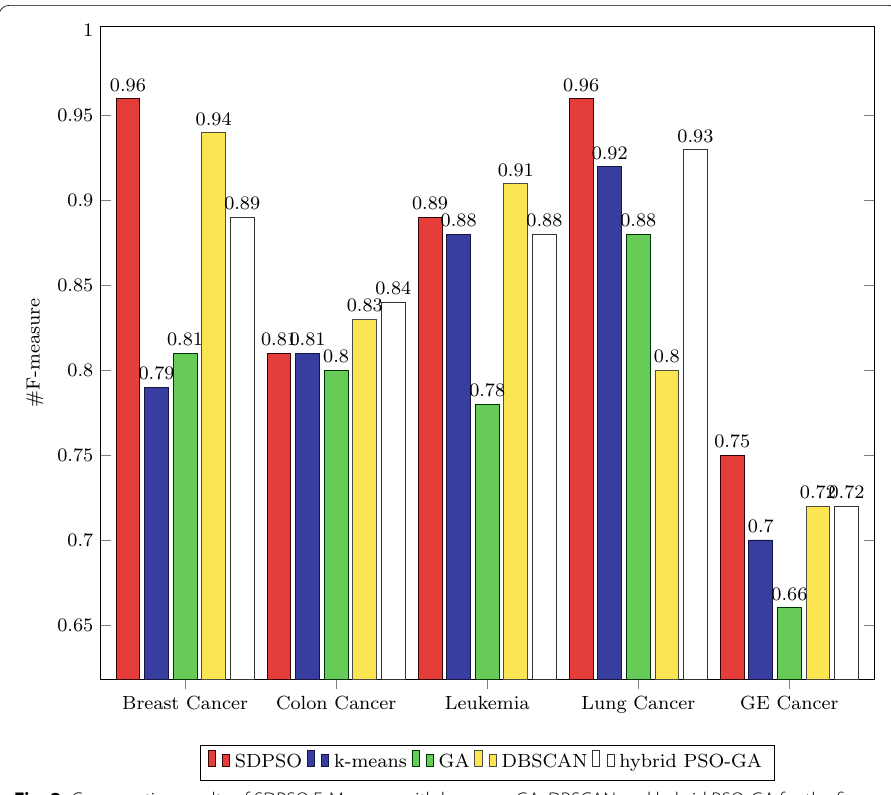
Fig. 2 Comparative results of SDPSO F-Measure with k-means, GA, DBSCAN and hybrid PSO-GA for the five datasets